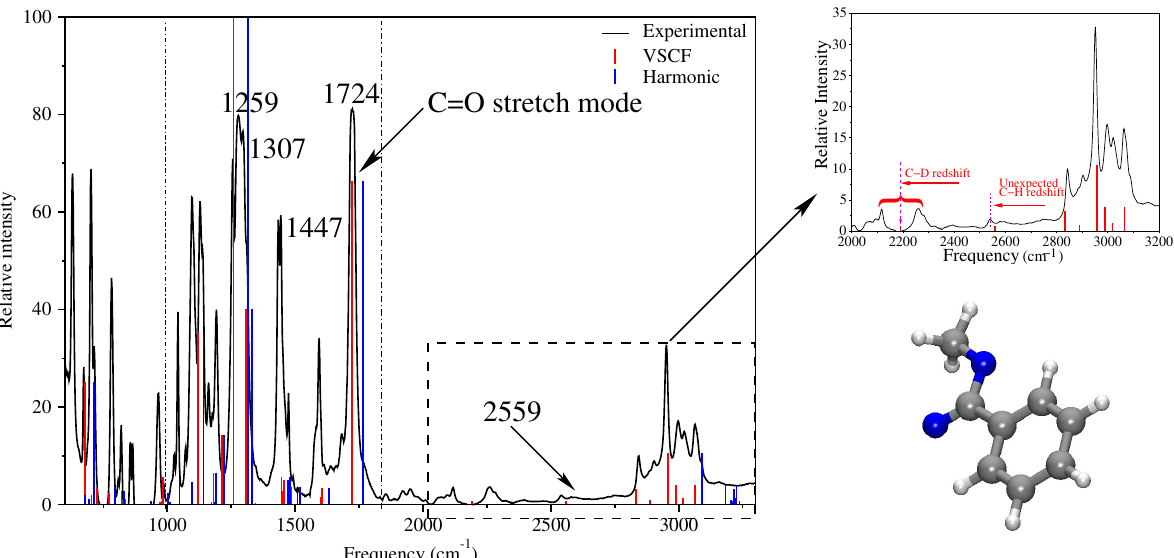
Figure 1. Experimental one-dimensional infrared (1DIR) spectra (black line) of deuterated MB. The calculated harmonic (blue sticks) and anharmonic (red sticks) vibrational frequencies are plotted along with experimental spectra [62]. The intensity of the calculated harmonic frequencies are also used to plot anharmonic